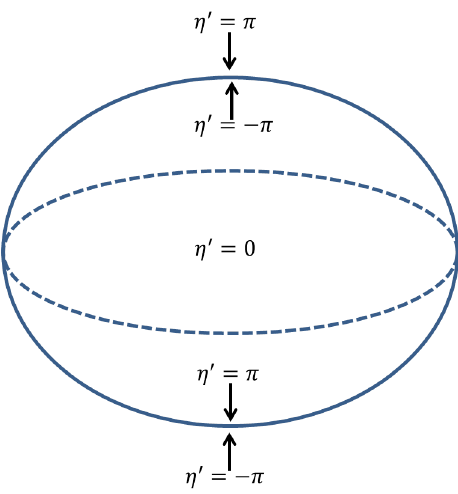
Figure 2: The value of η (cid:48) ∈ [ − π , π ] for the ansatz (28). The dashed line is the singular ring that connects the two η (cid:48) = π sheets. The value of η (cid:48) jumps by ± 2 π as one crosses the